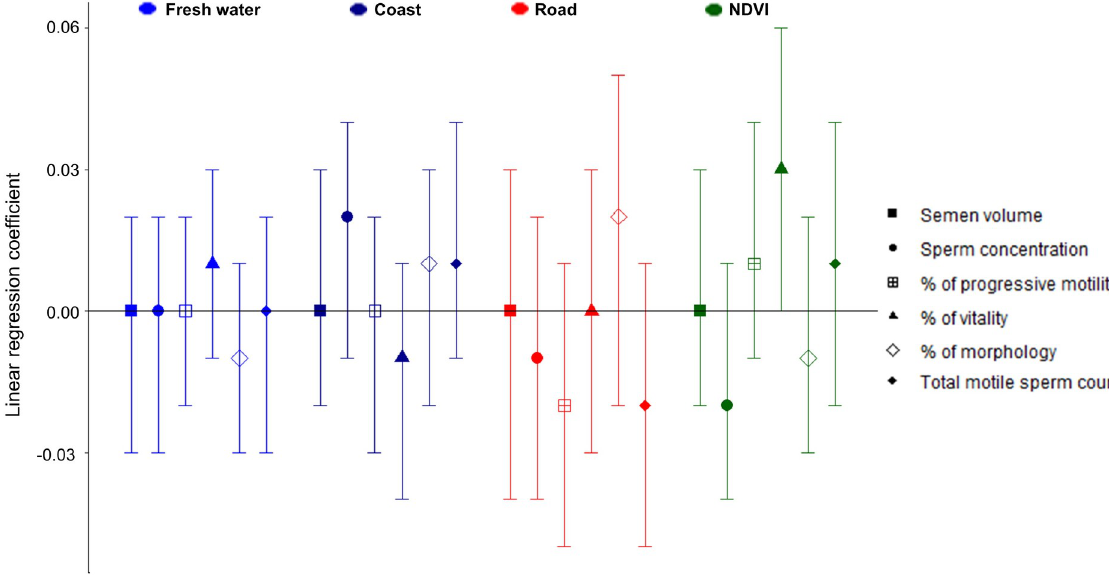
Fig 1. Association between six standardized semen parameters (z-scores) and built environment components in a multi-exposure model among 5,886 Korean infertile men. NDVI, Normalized Difference Vegetation Index. All coefficients are per interquartile range-increase of built environment components. Coefficients are calculated using a multivariable linear regression model including four built environmental components, age, body mass index, occupation, smoking, season of semen test, and administrative district of home address.